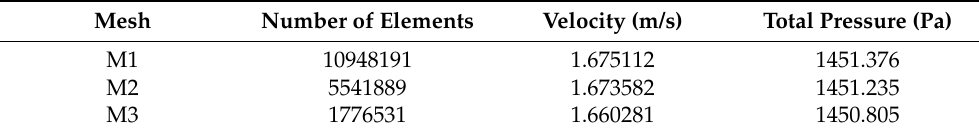
Table 2. Validation results of grid